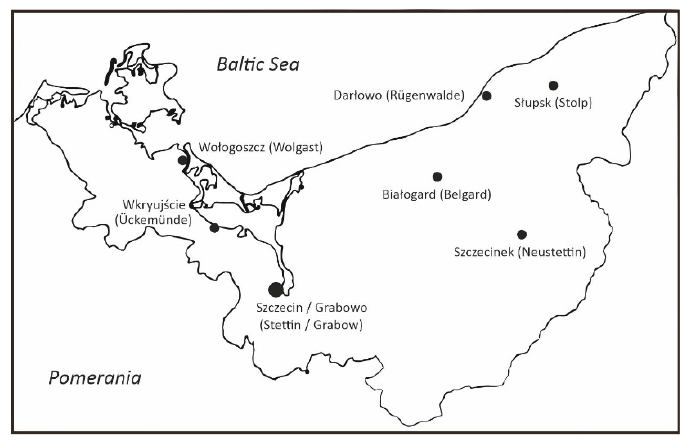
Figure 1. Locations of the prince’s castles in Pomerania, created by author.